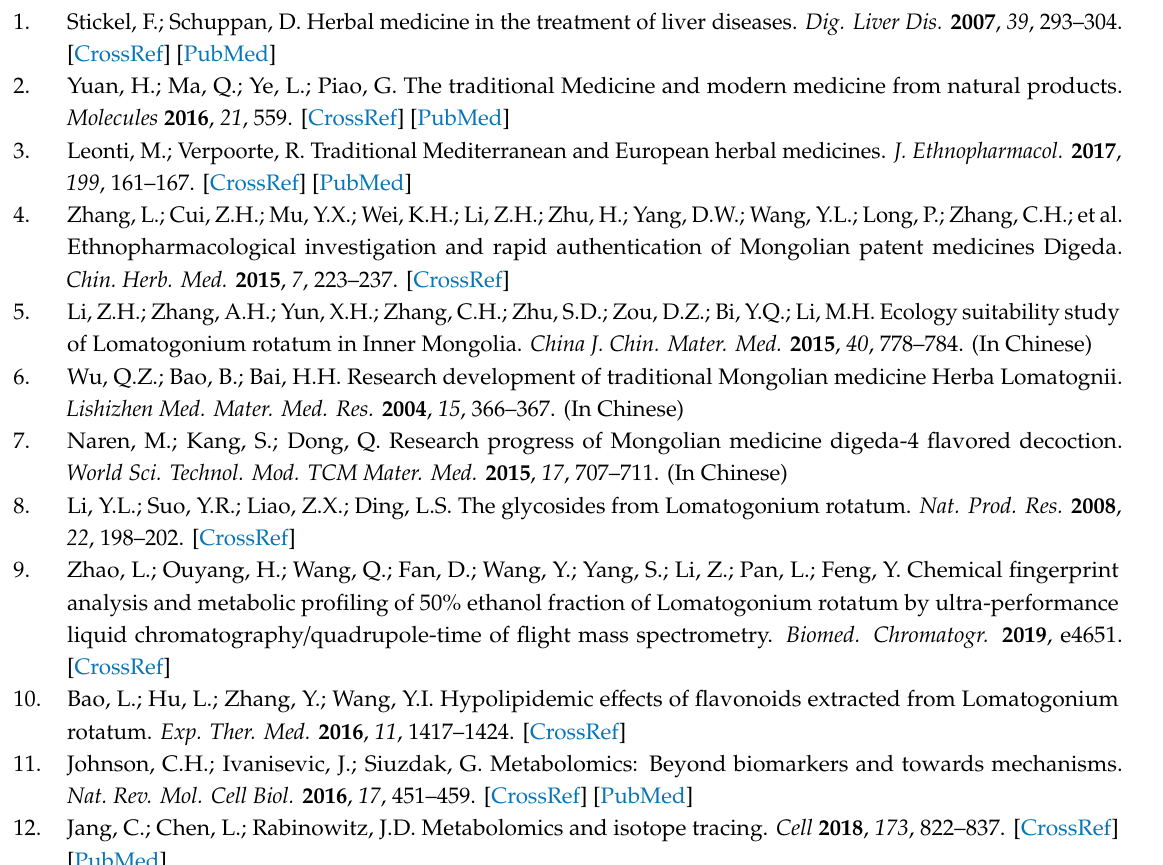
Figure S1: Total ion chromatograms of QC samples and selected top 12 peaks, A: GC-MS, B: LC-MS (ESI + ), C: LC-MS (ESI–). Figure S2: Plots of PCA and OPLS-DA. A: PCA plot of GC-MS data (R 2 X: 0.774; Q 2 : 0.603); B: OPLS-DA plot of GC-MS data (R 2 X: 0.717; R 2 Y: 0.948; Q 2 : 0.631); C: PCA plot of LC-MS data (R 2 X: 0.62; Q 2 : 0.53); D: OPLS-DA plot of LC-MS data (R 2 X: 0.737; R 2 Y: 0.878; Q 2 : 0.815). Figure S3: MS / MS spectra (ESI + and ESI–) of identified metabolites and the comparison with major fragments of metabolites in HMDB database. Figure S4: Result of metabolic pathway analysis through MetPA software. Table S1: The peak areas and retention times of top 12 peaks in QC samples (GC-MS). Table S2: The peak areas and retention times of top 12 peaks in QC samples (LC-MS). Table S3: Identified metabolites and their relative levels in the control, model, and LR